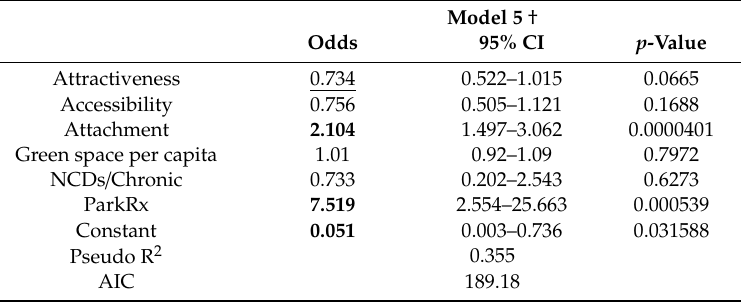
Table A2. Outcome model for mediation analysis (Model 5).